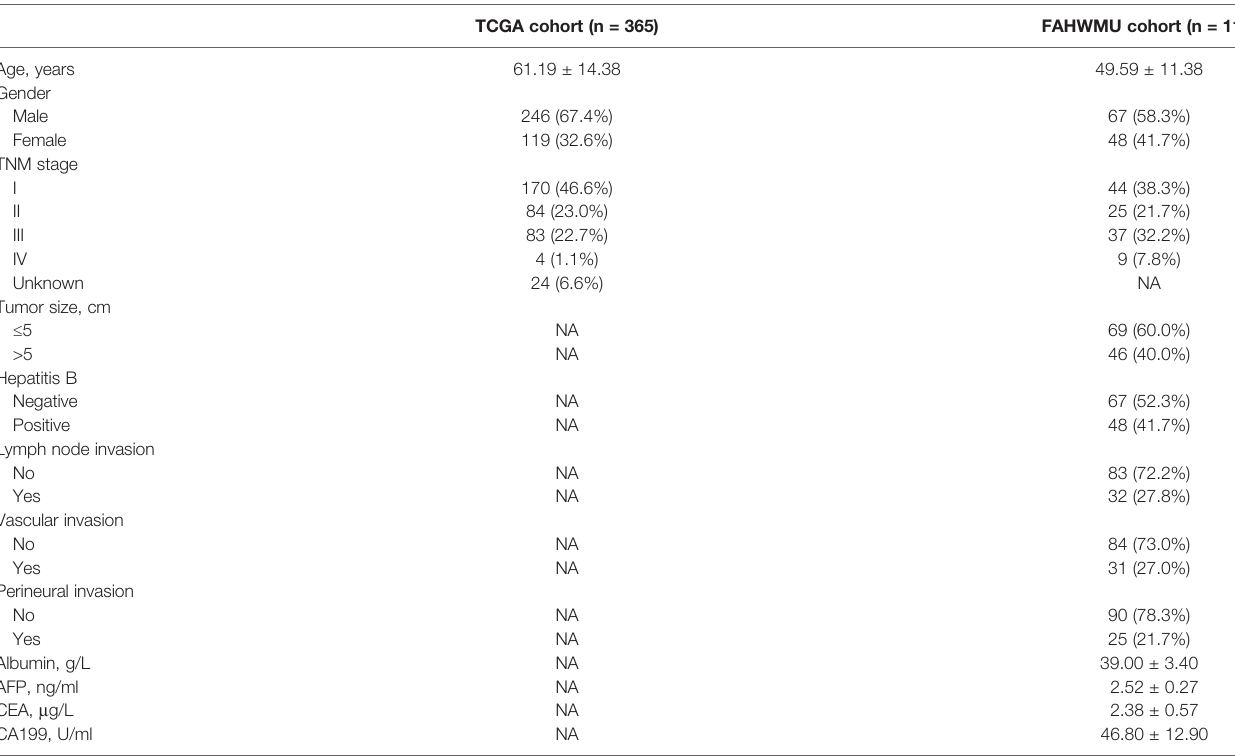
TABLE 1 | Clinical characteristics for HCC patients in TCGA cohort and the FAHWMU